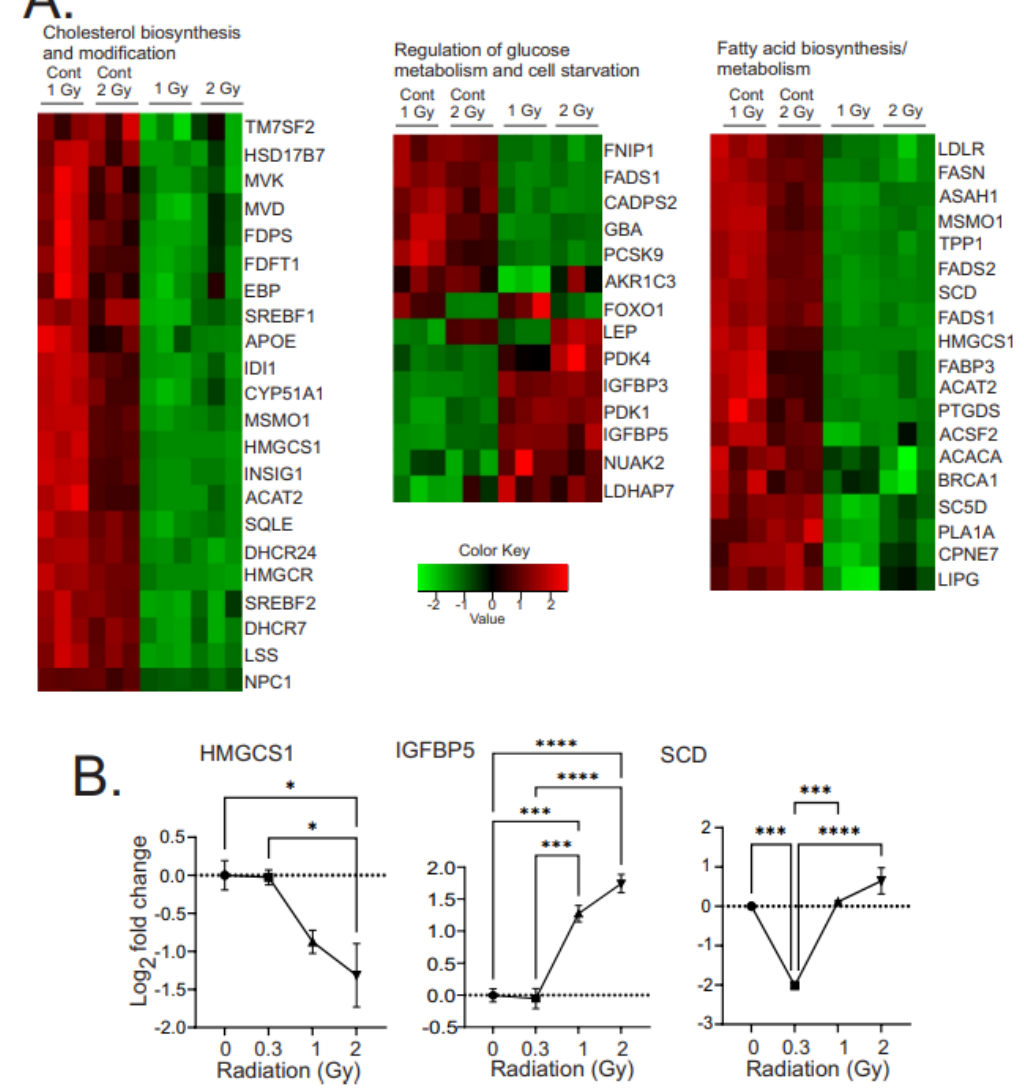
Figure 4. Heatmaps of gene expression changes in pathways for cholesterol biosynthesis and modification, glucose metabolism and cell starvation, and fatty acid biosynthesis and metabolism. ( A ). RNAseq was used to identify gene expression changes in primary human MSCs following 1 or 2 Gy (0.66 cGy/h) 60 Co irradiation. Control cells were cultured under identical conditions for 1 or 2 weeks. GO analysis was performed using DAVID and heatmaps were generated using genes with q < 0.05. Rows are centered and unit variance is applied to rows. ( B ). qPCR gene regulation using log base 2 scale fold change of genes supporting heatmaps of pathways. Data show averages ± SEM N = 3 biological replicates with two technical repeats; * indicates p < 0.05, *** indicates p < 0.001, **** indicates p < 0.0001, respectively, compared with sham irradiated control cells.